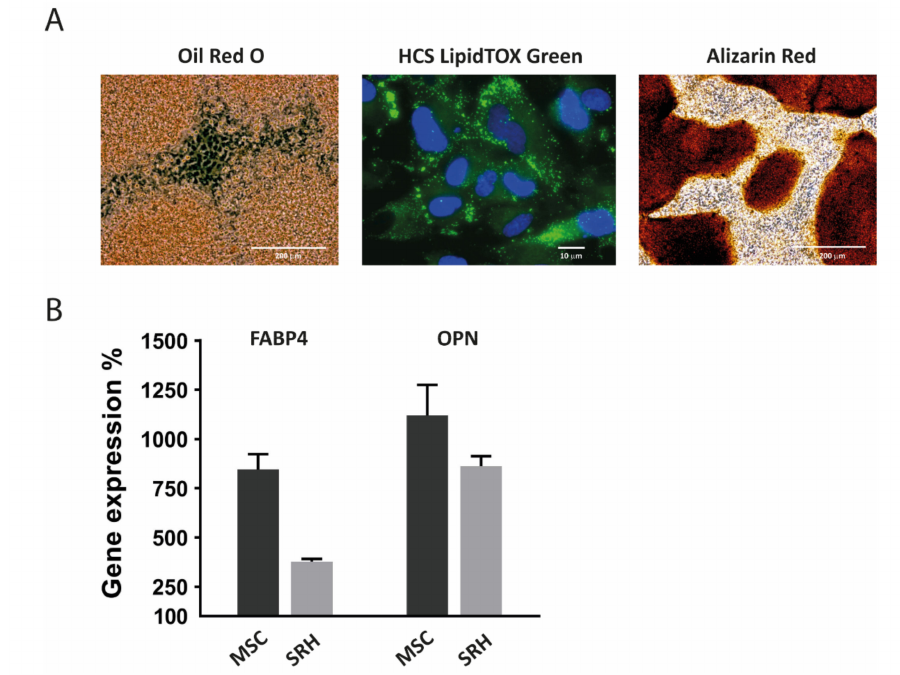
Figure 9. Adipogenic and osteogenic di ff erentiation. ( A ) After 21 days of adipogenic di ff erentiation) or osteogenic di ff erentiation SRH cells were examined for lipid droplet formation (Oil Red O and HCS LipidTOX ™ Green staining, Thermo Fisher Scientific, Waltham, MA, USA) or calcium deposition (Alizarin red staining, Carl Roth, Karlsruhe, Germany), respectively. ( B ) RNA expression levels for the adipogenic marker FABP4 and the osteogenic marker OPN after 21 days in adipogenic di ff erentiation medium (FABP4) or osteogenic di ff erentiation medium (OPN) relative to untreated controls are shown. Total RNA was extracted from mesenchymal stem cells (MSC) as well as the SRH cell line. Quantitative RT-PCR was performed in quadruplicate and normalized to the house keeping gene TBP . Error bars indicate the standard